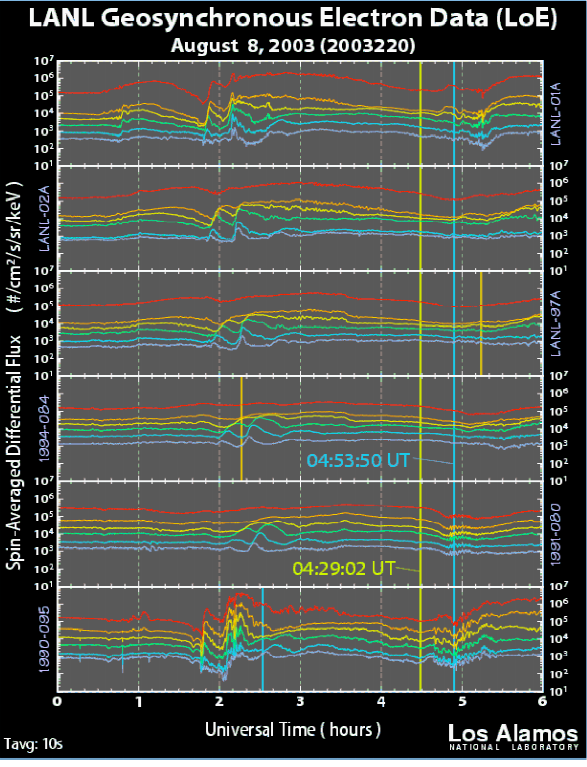
Figure 5 Fig. 5. The intensities of energetic electrons at several LANL geo- stationary